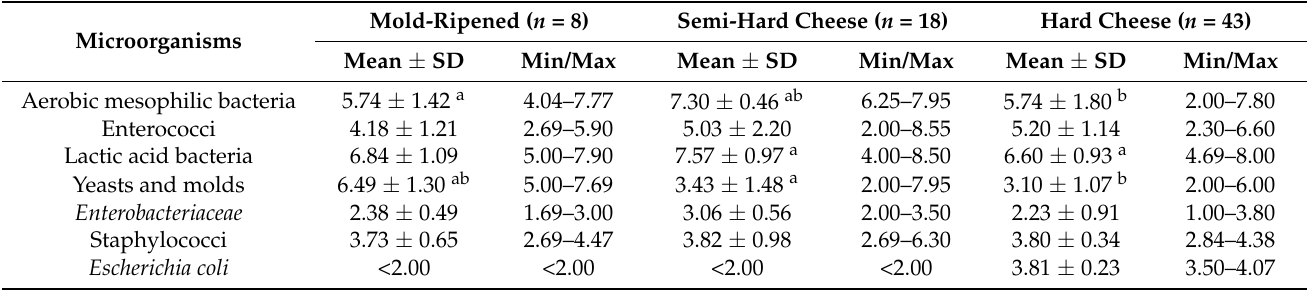
Table 2. Microbial population counts (log 10 CFU/g) in different cheese types.